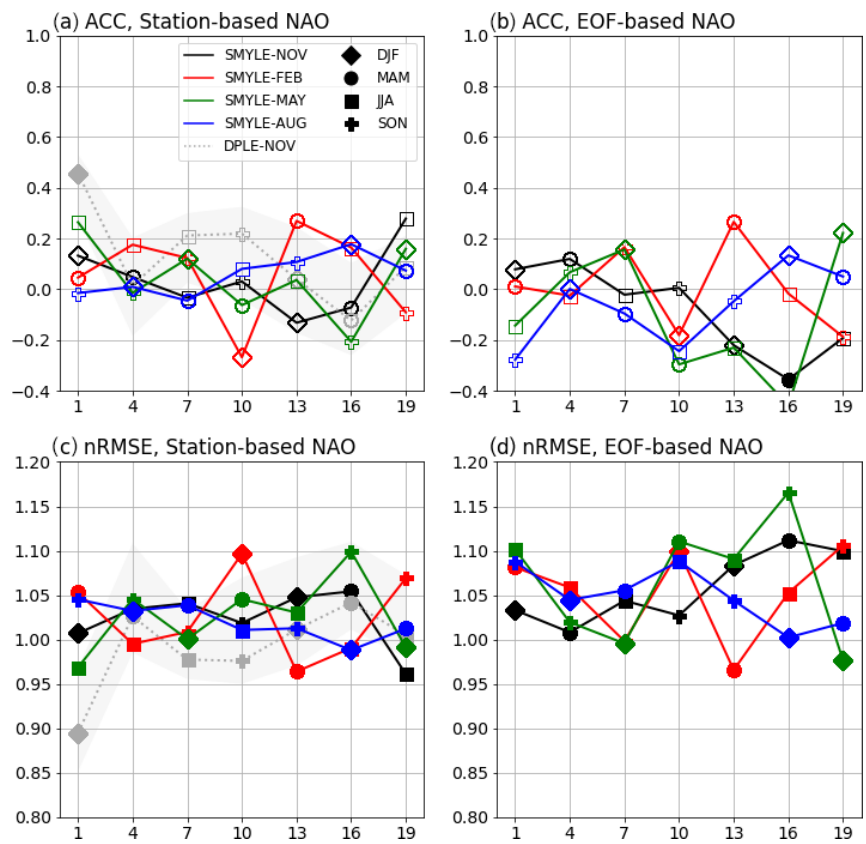
Figure B7. Identical to Fig. 7 except SMYLE and DPLE data are subsampled to only include forecasts initialized in years 1981–2015.